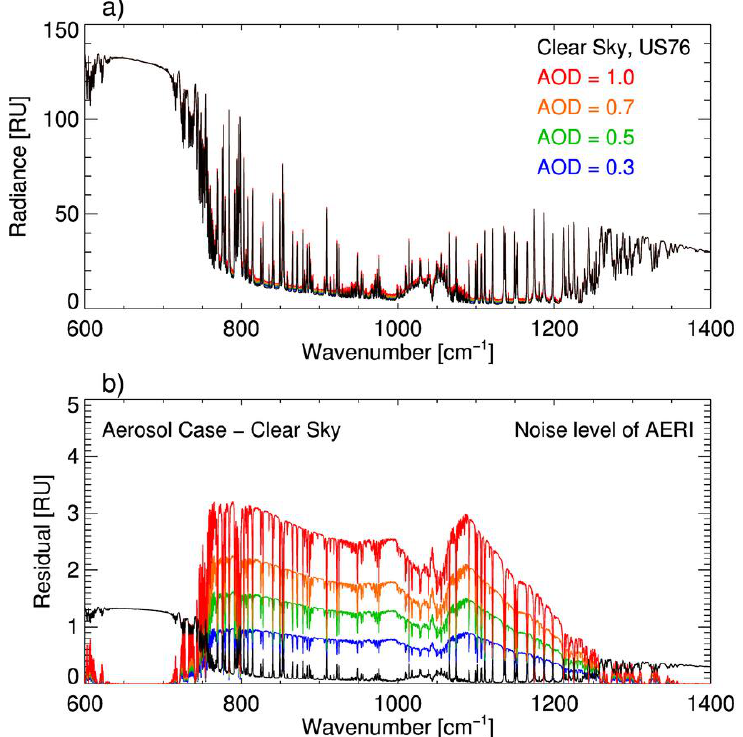
Figure 6. ( a ) The simulated radiance from LBLDIS for clear sky (black) and various AOD conditions ranging from 0.3 to 1.0. ( b ) The residual of radiances between clear sky and each AOD state. The aerosol type was CA, and the US76 standard atmosphere model was used for the thermodynamic profile. Table 2. Spectral region used in the retrieval of temperature, water-vapor mixing ratio, and AOD. State Vector Starting Wavenumber (cm − 1 ) Ending Wavenumber (cm − 1 )